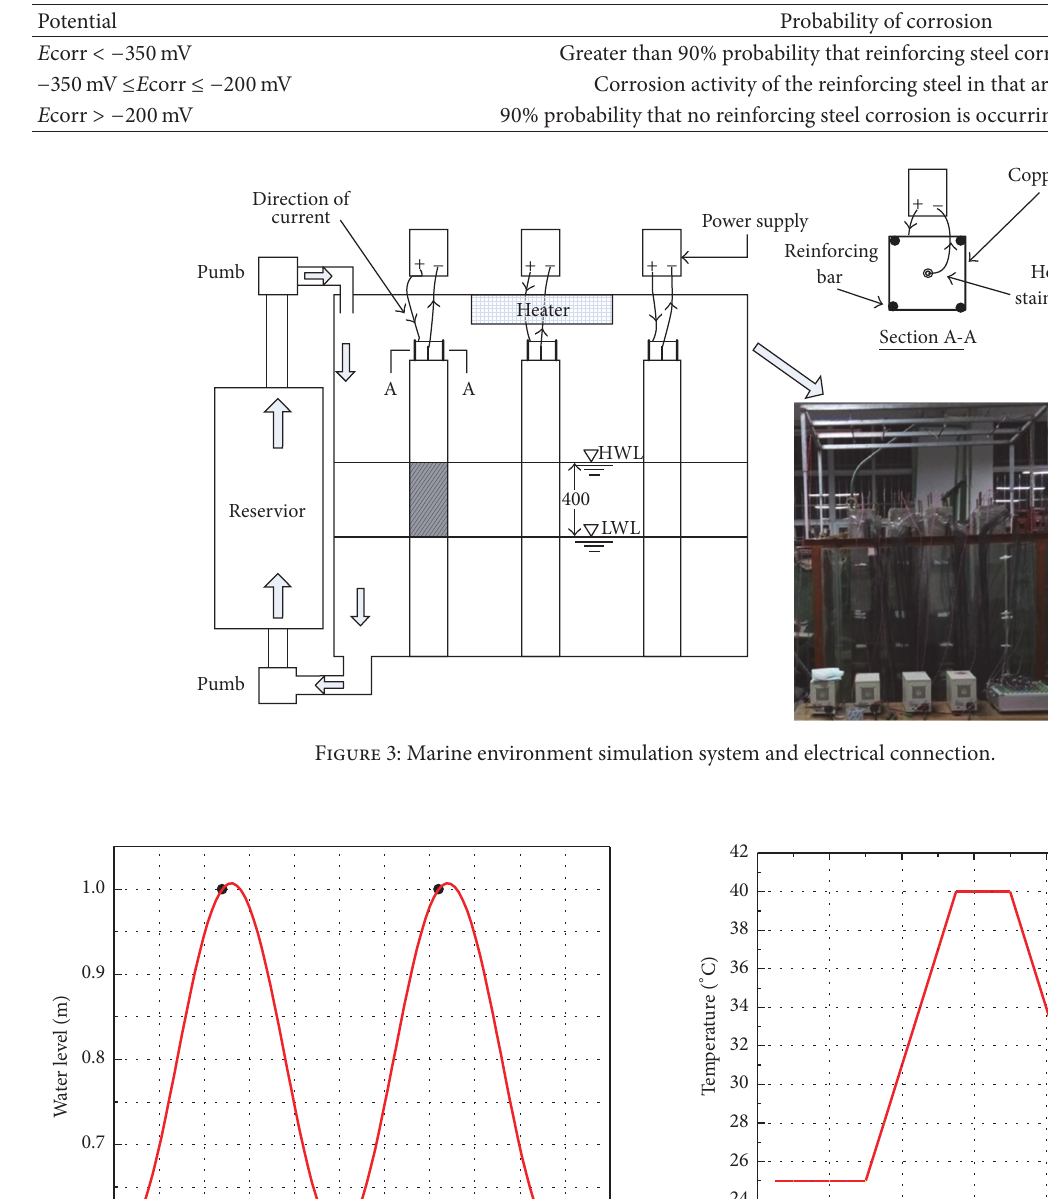
Table 3: Dependence between potential and corrosion probability.